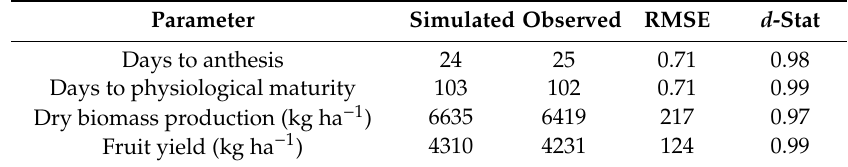
Table 2. Simulated and observed mean values for anthesis, maturity, fruit yield, and biomass production at physiological maturity and their respective statistical indices of tomato variety